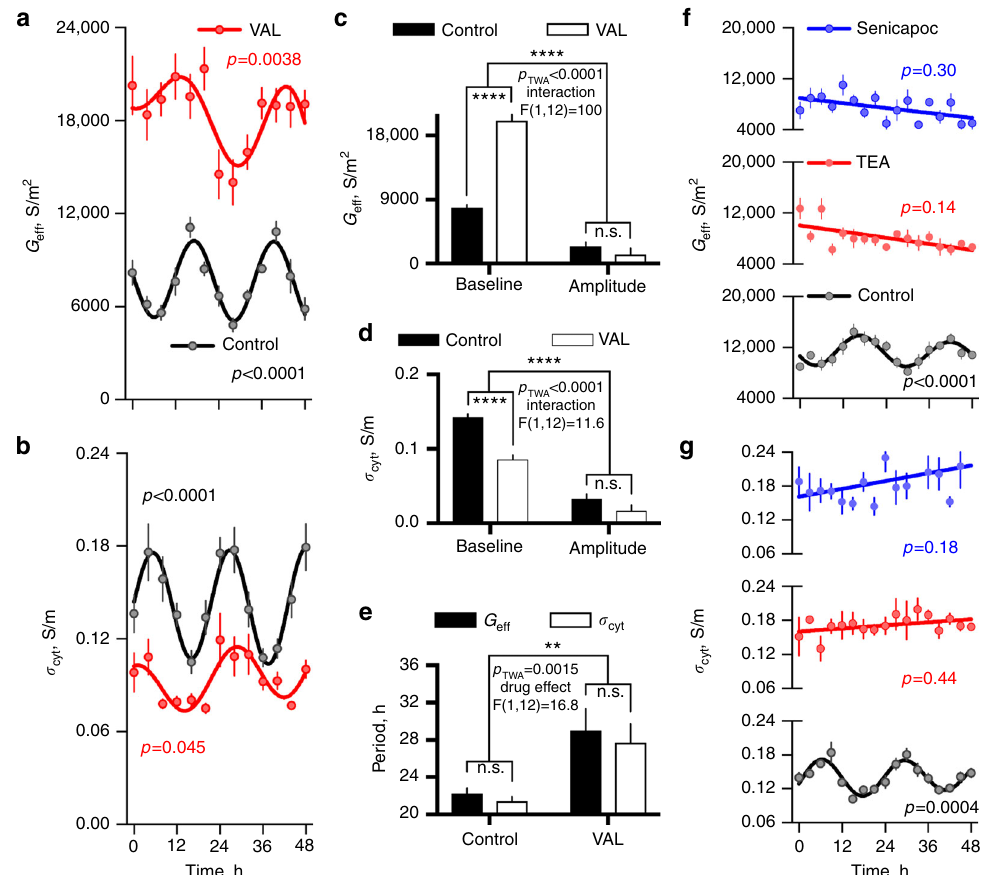
Fig. 5 RBC circadian rhythms are affected by perturbation of K + transport. The data points report DEP measurements of G eff ( a ), and σ cyt ( b ), in isolated RBCs over 2 days in the presence of 30 nM valinomycin or vehicle control (mean ± SEM, n = 4 biological replicates, cosine fi t p value reported). c – e Valinomycin treatment had signi fi cant effects on baseline G eff and σ cyt as well as lengthening circadian period of oscillation measured for both DEP parameters, without affecting the amplitude of their oscillation; two-way ANOVA p values ( p TWA ) and F statistics for interaction or drug effect are indicated, as well as selected Fisher ’ s post-test p values. f , g The data points report DEP measurements of G eff and σ cyt in isolated RBCs over 2 days in the presence of 11 nM senicapoc, 15 mM TEA or vehicle control, mean ± SEM, n = 4 biological replicates. P values in graphs a , b , f and g indicate report the probability that data series are better described by a damped cosine model than the null hypothesis (straight line); for p > 0.05 the straight line fi t is shown, for p < 0.05 the damped cosine fi t is shown (solid